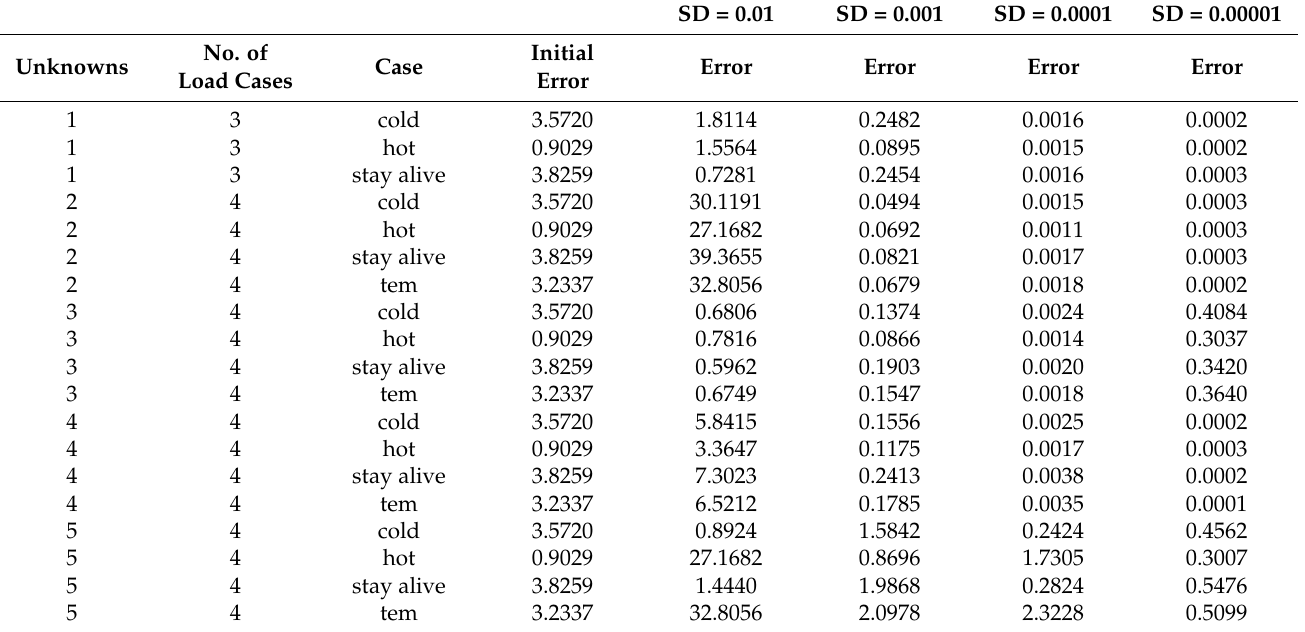
Table 16. Errors obtained for predicted temperatures for transient 16 nodes